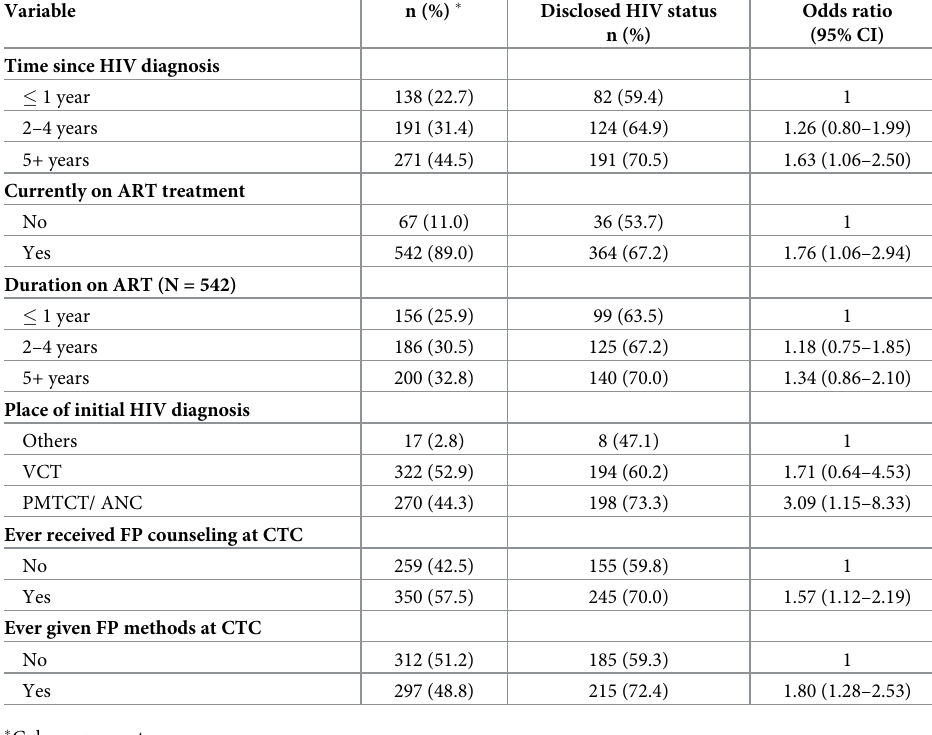
Table 3. Clinical characteristics associated with HIV-status disclosure in Kilimanjaro (N = 609).